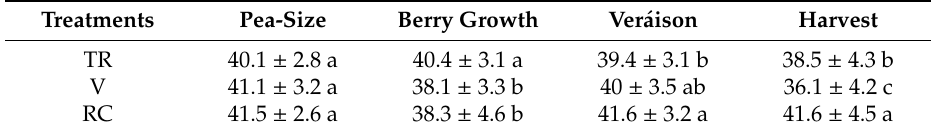
Table 1. E ff ect of soil management on leaf SPAD index in 2015–2016. (Values are means ± SD).